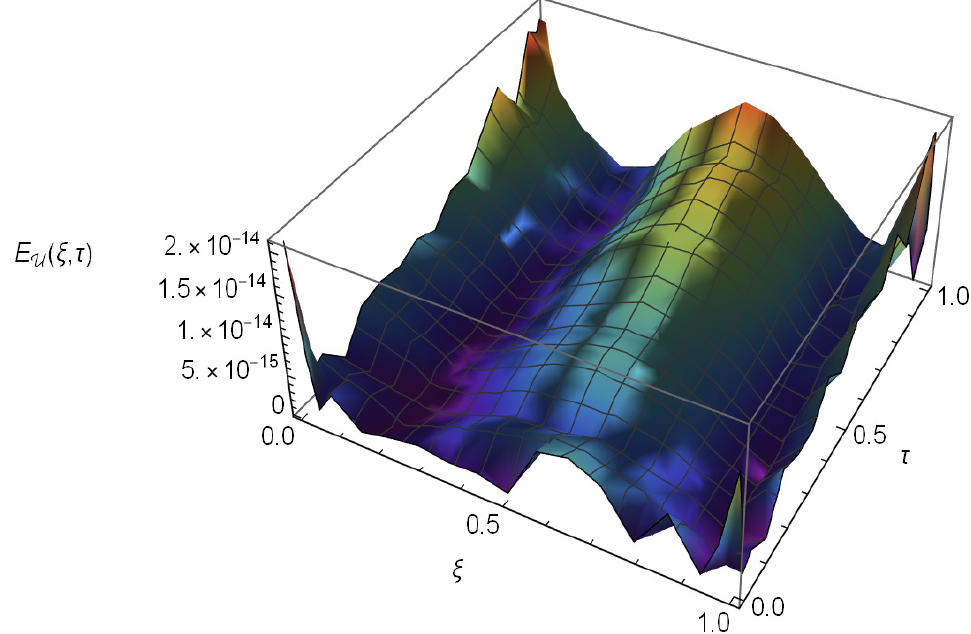
Figure 11. Absolute errors graph of the problem (33),where σ 1 = (cid:36) 1 = σ 2 = (cid:36) 2 = 0, ν = 0.9 and N = M = 16.